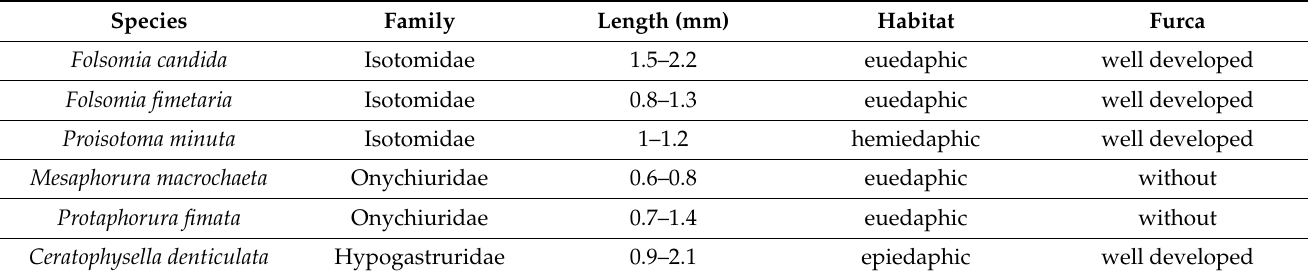
Table 1. Morphological and ecological traits of the collembolan species used in the avoidance